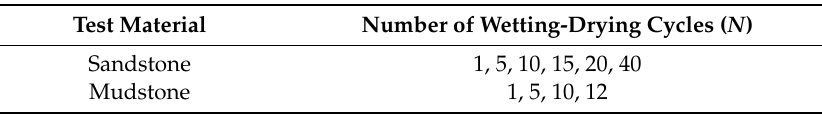
Table 2. Testing scheme.